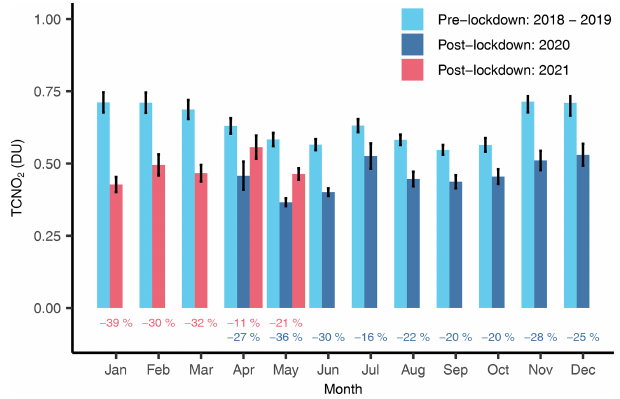
Figure 4. Monthly mean seasonal cycle of TCNO 2 in Upper West Manhattan pre-lockdown (December 2017–December 2019, cyan) and post-lockdown (April 2020–December 2020, blue, and January–May 2021, red), as measured by PSI #135 (30min aver- aged data; 95% confidence intervals indicated by error bars; data not available during January–March 2020). The percentage (%) change is also shown below each